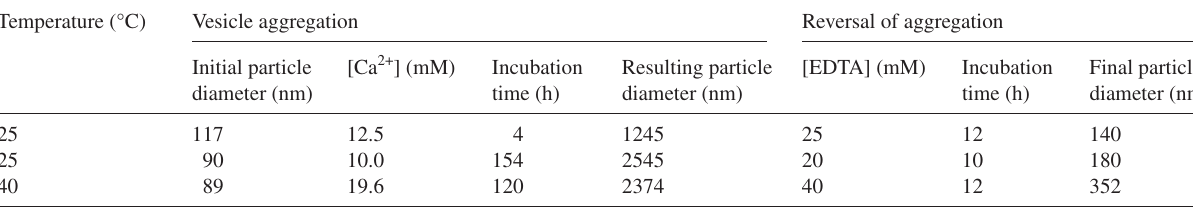
Table 1. Effect of EDTA on Ca 2+ -induced aggregation of PLFE vesicles. Temperature (°C)